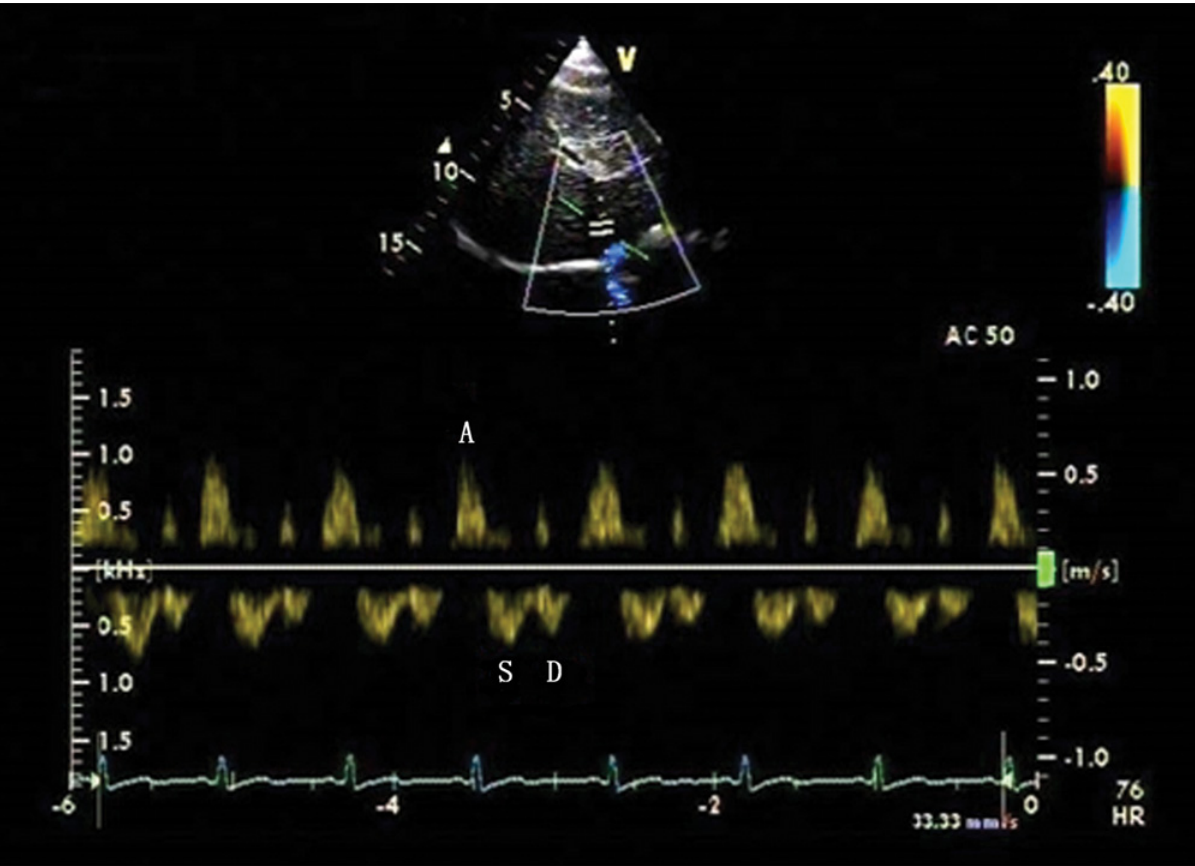
Fig 2. Four-phasic Doppler flow spectra of the MHV in the pulmonary hypertension (PH) group. Doppler spectra of MHV obtained from a patient with ventricular septal defect with the MPAP of 80 mmHg. The four-phasic waveform includes S wave, D wave, A wave and ventricular reversal (V wave) waves. Compared with the control group, the spectra had a higher value of the peak flow velocity and the velocity time integral (VTI) of A wave, and a lower value of peak flow velocity and VTI of S wave and D wave.